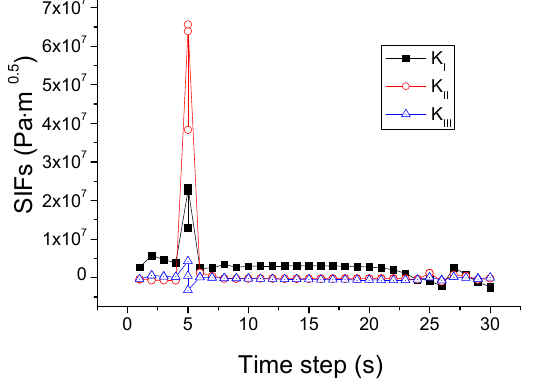
Figure 19. Variation of SIFs associated with the criterion based on maximum principal stress.